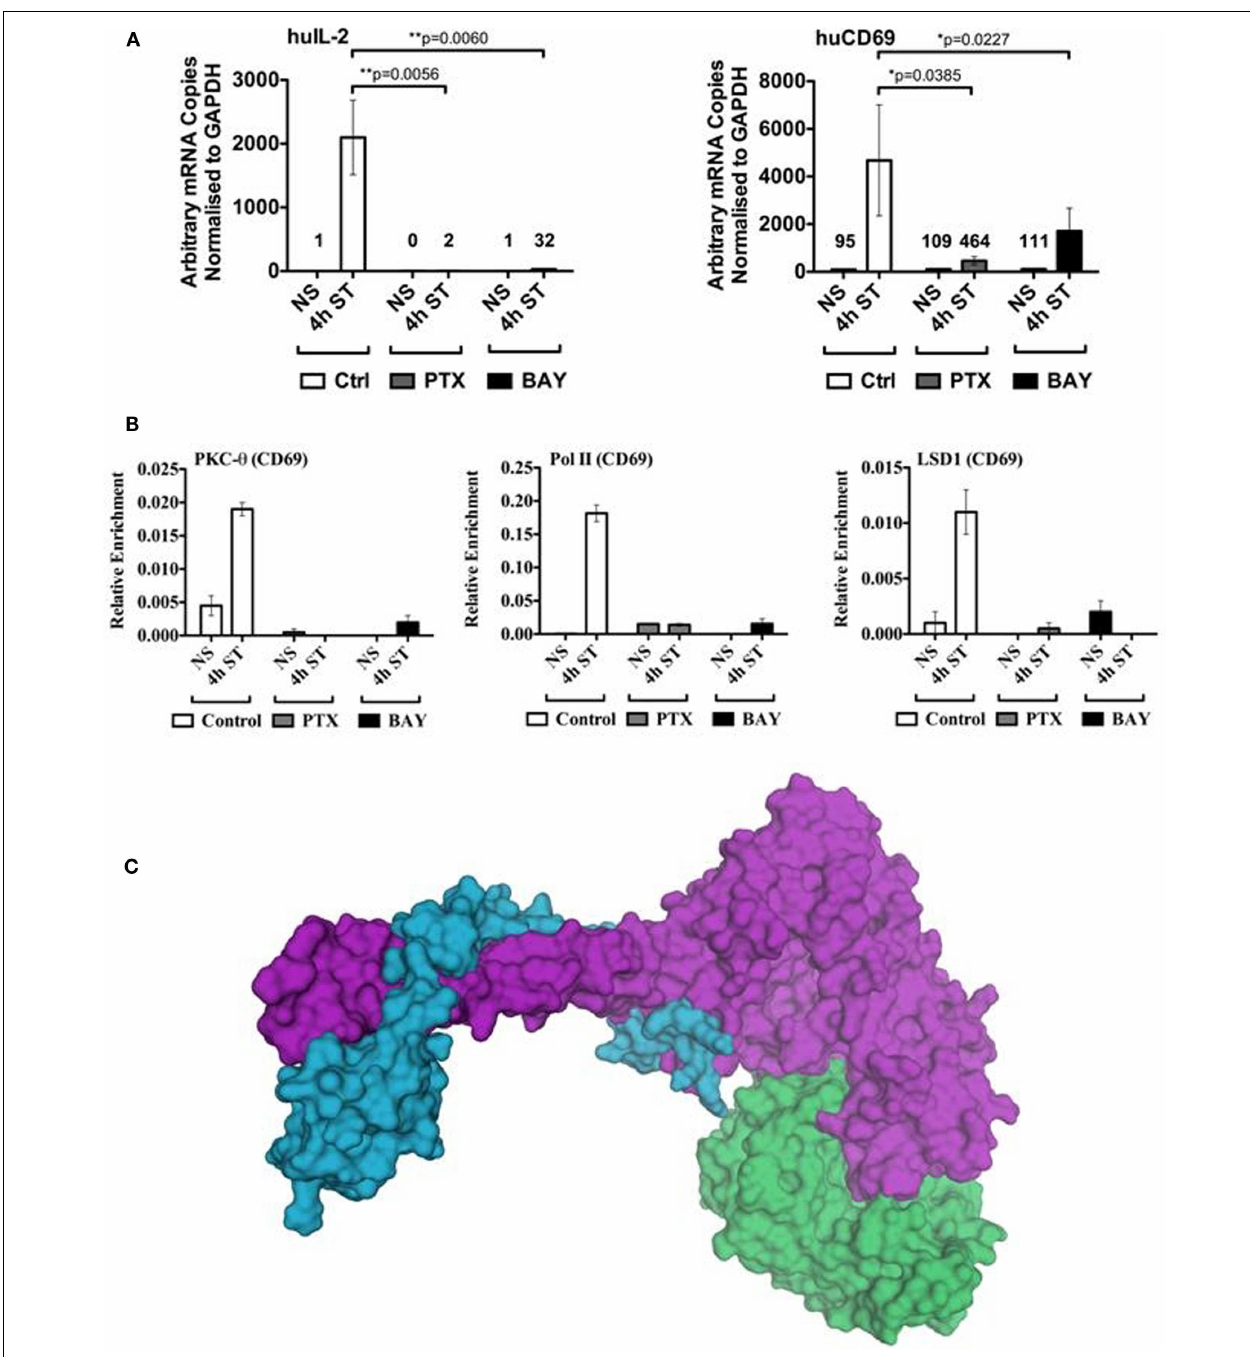
inhibited samples was determined by a two-tailed paired t -test using GraphPad Prism 5.03. PKC- θ , Pol II, and LSD1 ChIP experiments were performed on the samples described in (A) . (B) Sybr-green real-time PCR was used to detect the relative enrichment of these proteins across the CD69 promoter ( − 214 to − 52 relative to the transcription start site). (C) The catalytic domain of PKC- θ (green, pdb code 2JED) is modeled interacting with the LSD1-CoREST complex (purple and blue, respectively, pdb code 2IW5). In this model the peptide-binding groove of PKC- θ contacts the SWIRM and amine oxidase domains of